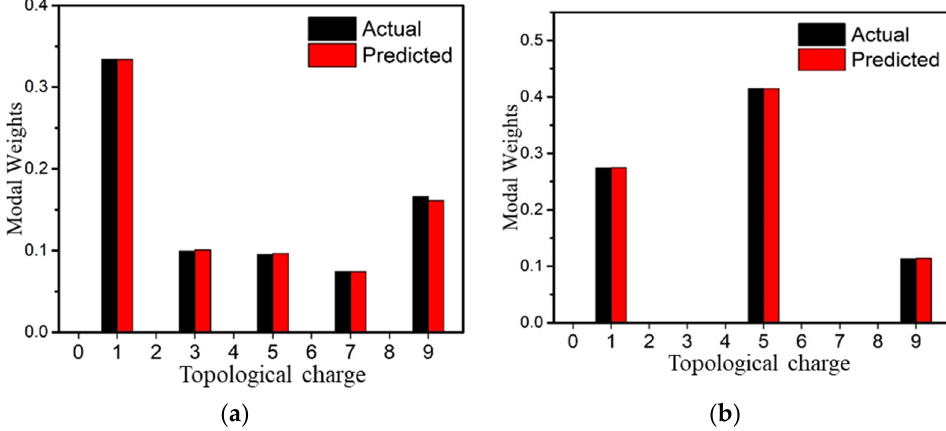
Figure 5. Comparison of the predicted and true values of the mode weights for the non-adjacent topological charge condition. ( a ) The cases of l = 1, 3, 5, 7, 9; ( b ) The case of l = 1, 5, 9.